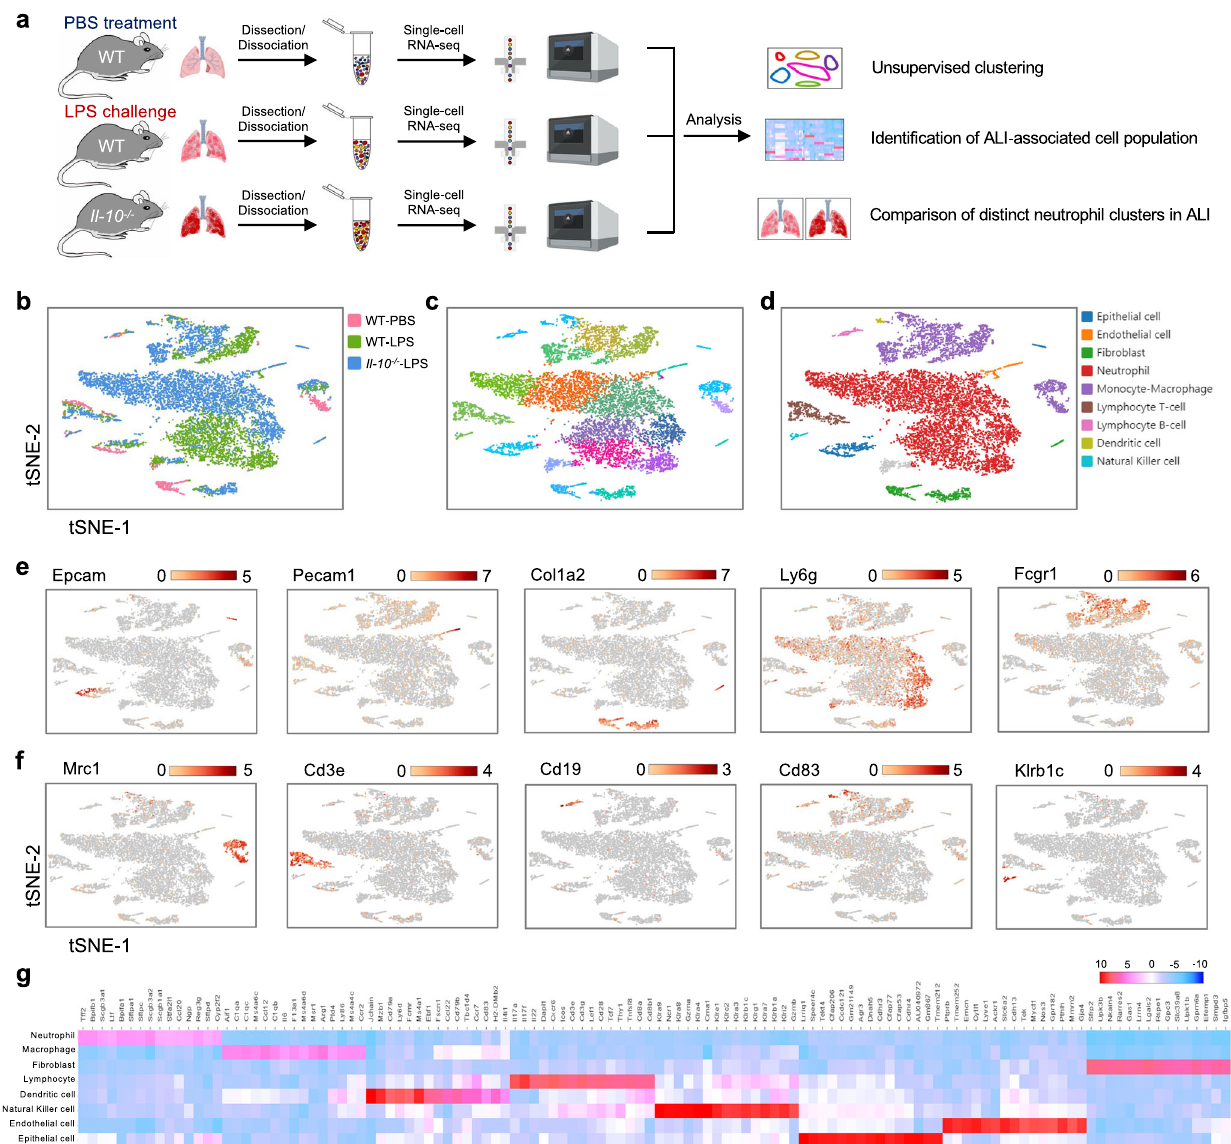
Fig. 3 | Identi fi cation of distinct cell populations in mouse lung tissues by Single-cell RNA sequencing. a Schematic diagram of our experimental design. Some fi gure elements were created with BioRender.com. b , c The t-SNE repre- sentationofalignedgeneexpressiondatainsinglecellscollectedfromWTcontrol (1,129 cells), WT LPS-treated (4,478 cells) and Il-10 − / − LPS-treated (6,518 cells) mouse lung samples showed cellular origins ( b ) and partitioned into 18 distinct clusters ( c ). d Unsupervised clustering identi fi ed 9 major pulmonary cell subsets.